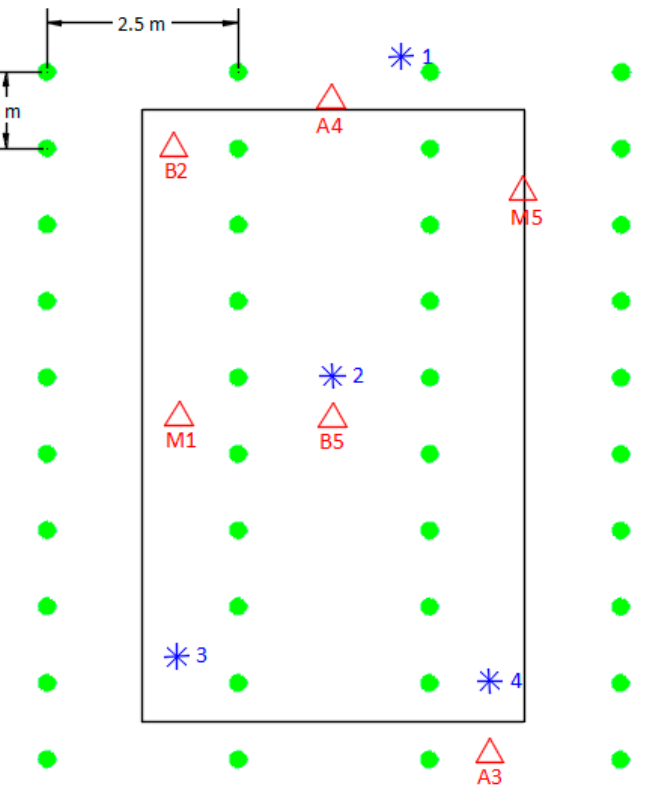
Figure 1. Diagram of TLS data acquired from the FARO Focus3D M70 scanner in one of the study plots. Stools represented by green circles; scan positions represented by blue asterisks; spheres represented by red triangles.